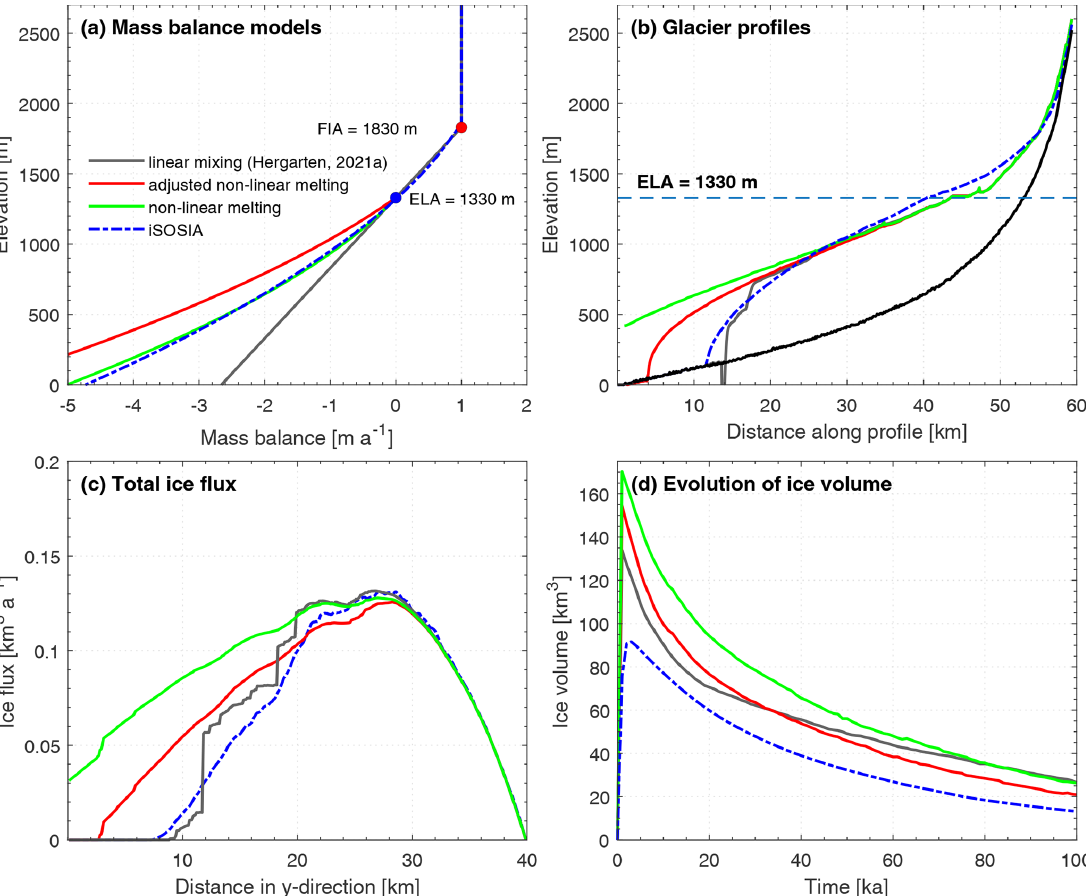
Figure 5. Comparing the ice mass balance models. (a) Different altitude-dependent mass balance models for iSOSIA (dashed blue line) and OpenLEM (solid lines). Impact of the mass balance models on (b) ice thickness along the cardinal flow line, (c) total ice flux in the y direction and (d) total ice volume. Note that (b) and (c) represent the ice configuration after 4ka, which coincides with the time of the maximum ice volume of